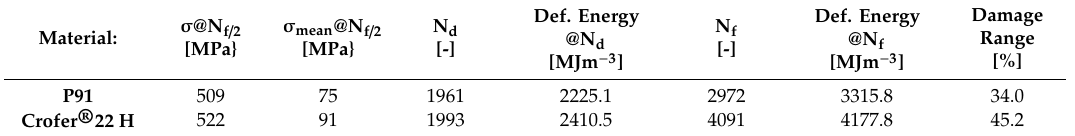
Table 2. Half-life stress range, damage initiation N d , technical TMF lifetime N f and damage